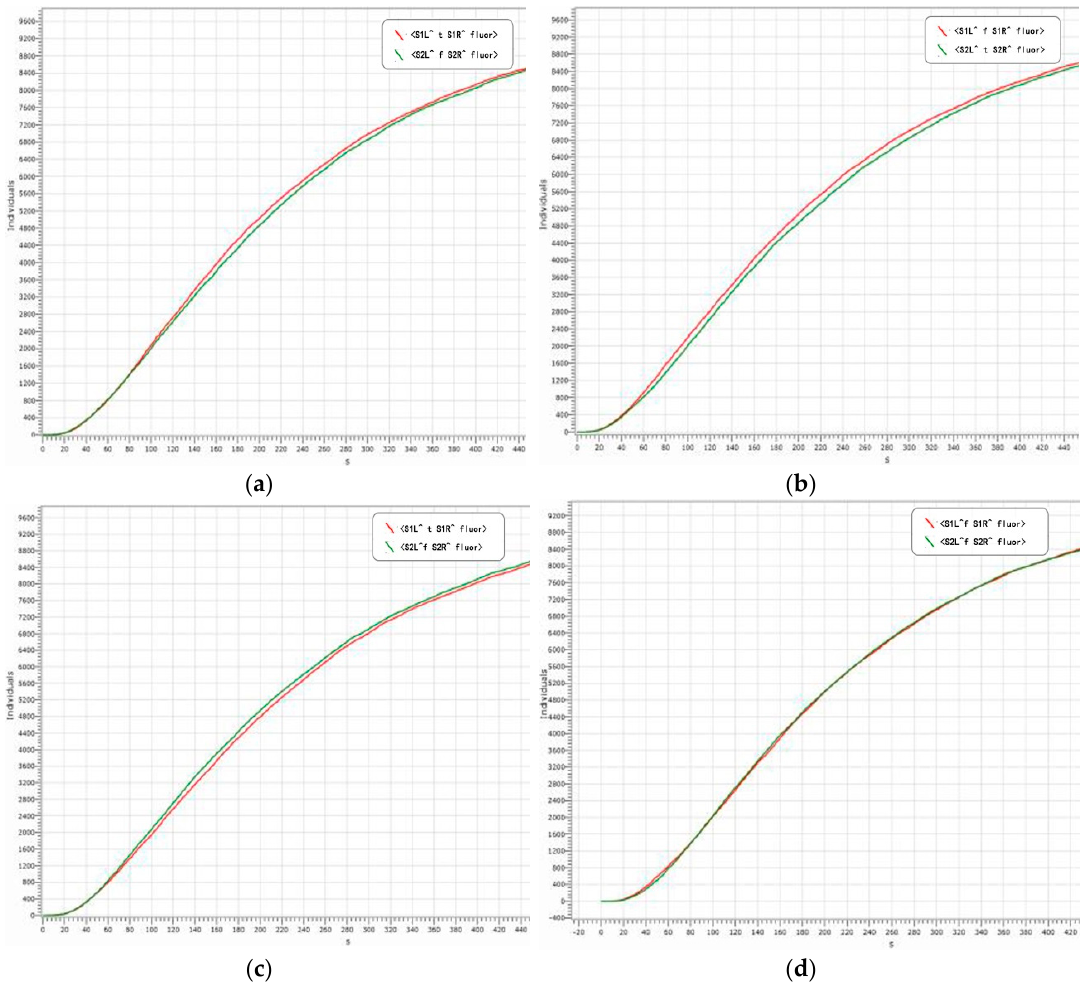
Figure 12. ( a ): ( a ): A (cid:2868) = 1,B (cid:2868) = 0,S (cid:2868) = 1,S (cid:2869) = 0 ( b ): A (cid:2868) = 1,B (cid:2868) = 1,S (cid:2868) = 0,S (cid:2869) = 1 ( c ): A (cid:2868) = 0,B (cid:2868) = Figure 12. ( a ): A 0 = 1,B 0 = 0,S 0 = 1,S 1 = 0; ( b ): A 0 = 1,B 0 = 1,S 0 = 0,S 1 = 1; ( c ): A 0 = 0,B 0 = 1,S (cid:2868) = 1,S (cid:2869) = 0 ( d ): A (cid:2868) = 0,B (cid:2868) = 0,S (cid:2868) = 0,S (cid:2869) = 0 . 1,S 0 = 1,S 1 = 0; ( d ): A 0 = 0,B 0 = 0,S 0 = 0,S 1 =